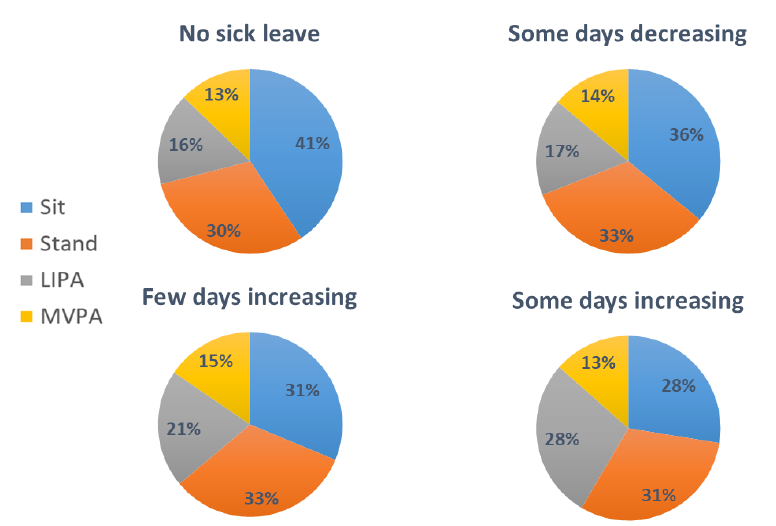
Figure 1. Mean work-time composition (% time) of physical behaviors (i.e., sitting, standing, LIPA (light physical activity), and MVPA (moderate-to-vigorous physical activity)) in each sick- leave